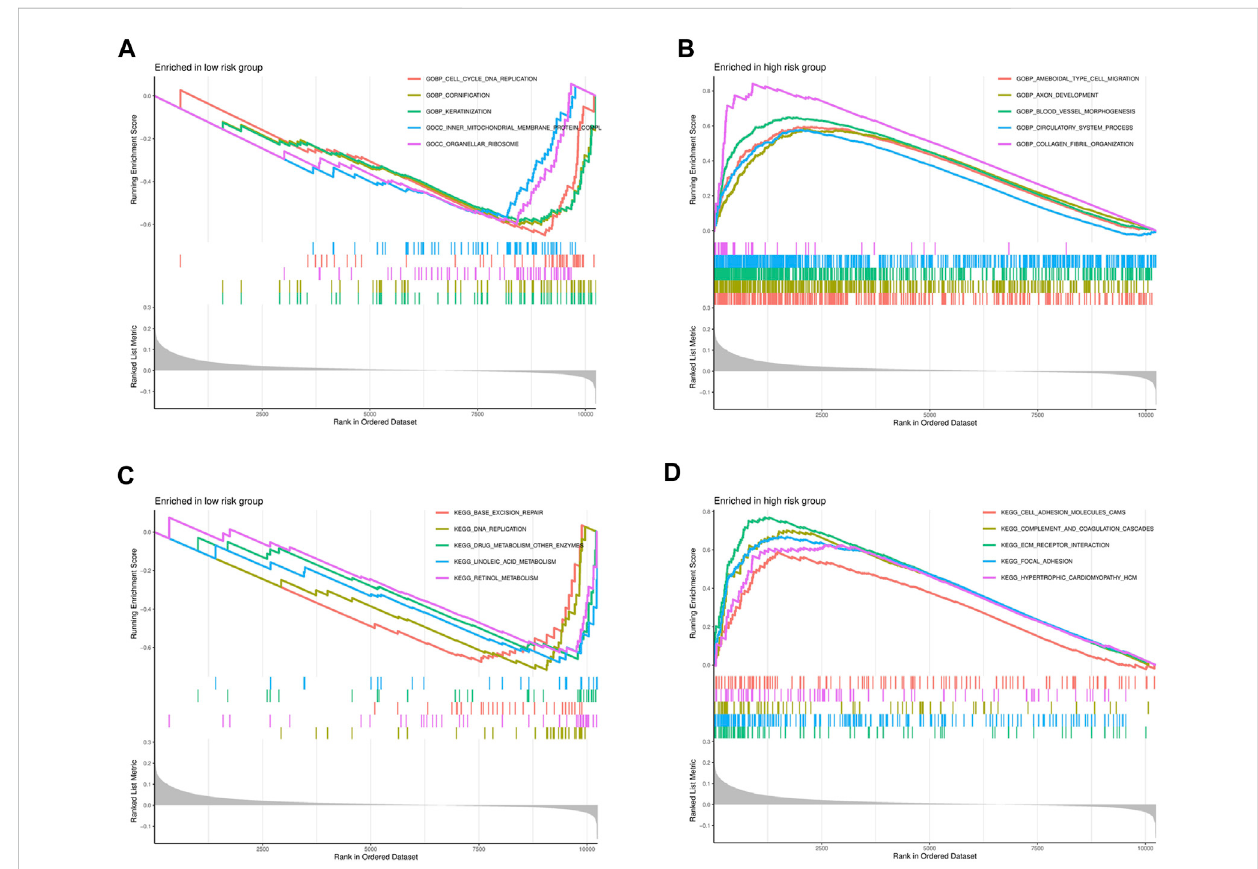
FIGURE 9 Signi fi cantly enriched GO pathways and KEGG pathways in the entire cohort by GSEA. (A) The GSEA analysis for GO pathway in the low-risk group. (B) The GSEA analysis for GO pathway in the high-risk group. (C) The GSEA analysis for KEGG pathway in the low-risk group. (D) The GSEA analysis for KEGG pathway in the high-risk